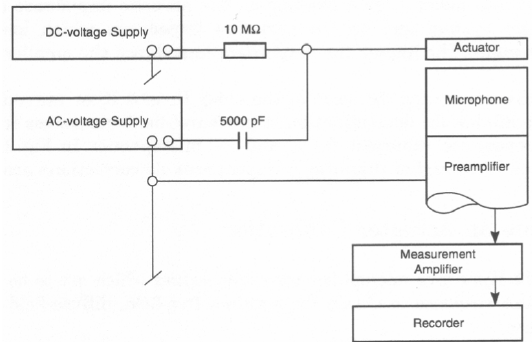
Fig. 12. Principle of electrostatic actuator voltage